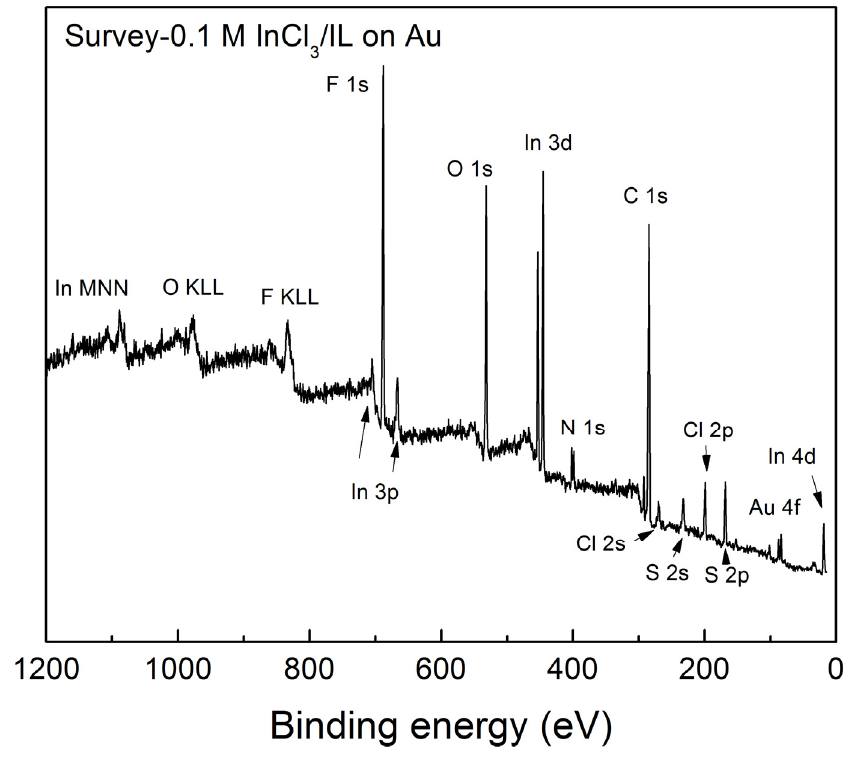
Figure 4. X-ray photoelectron spectroscopy (XPS) survey spectrum of 0.1 mol/L InCl 3 in [Py 1,4 ]TFSI in the cell setup.